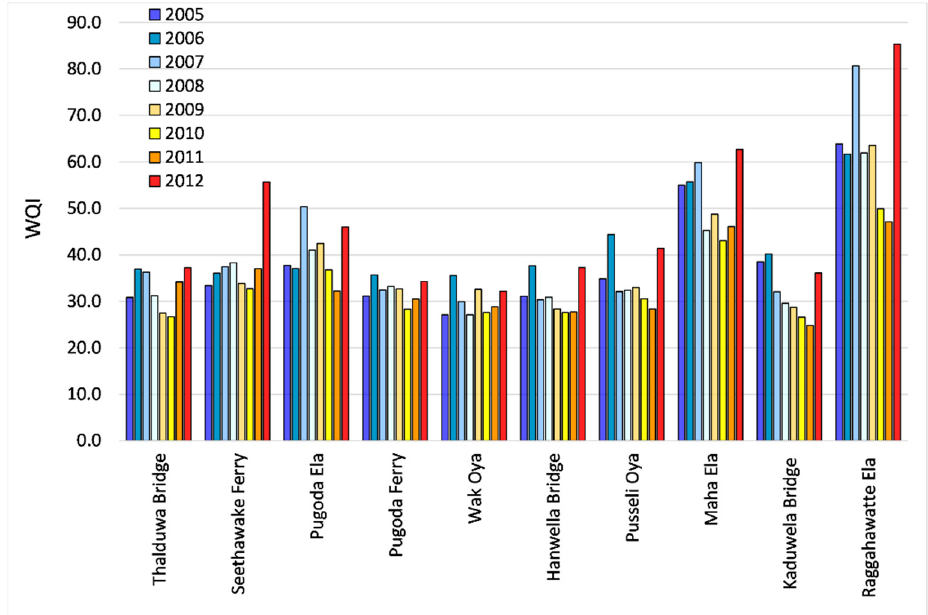
Figure 4. Spatiotemporal variation of calculated WQI along the Kelani River.